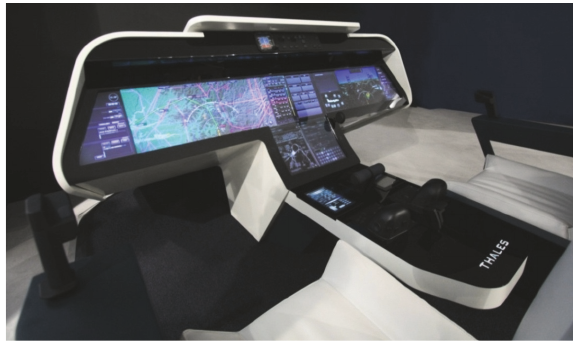
Figure 1: A picture of a prototype of future aircraft cockpit as envisioned by the ODICIS project (Copyright Thales